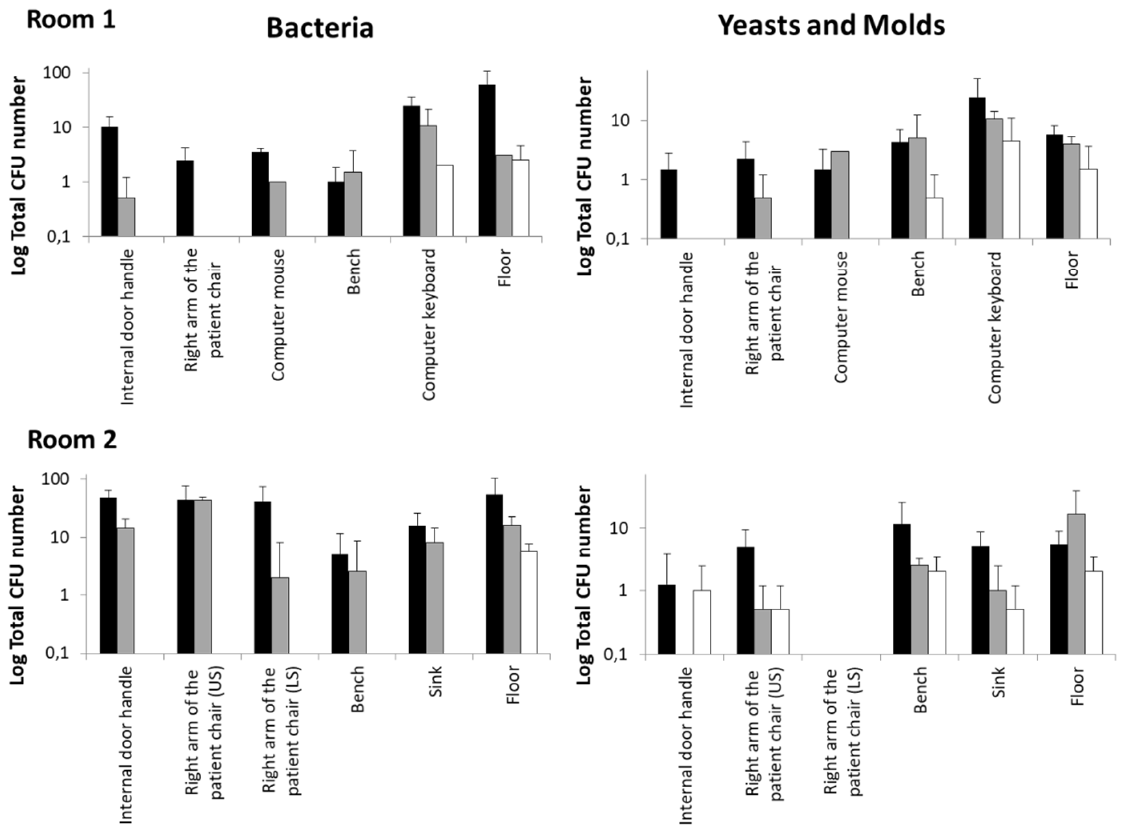
Figure 3. Outpatient room disinfection with the UV ‐ C robotic systems R2S compared to standardized manual protocol based on chlorine solution nebulization. Mean ± SD data were calculated from the two determinations described in Materials and Methods. The CFU number of bacteria, yeast, and molds was assessed as described in the Materials and Methods section. Black bars: CFU before sanification; gray bars: after manual disinfection; white bars: after R2S disinfection.